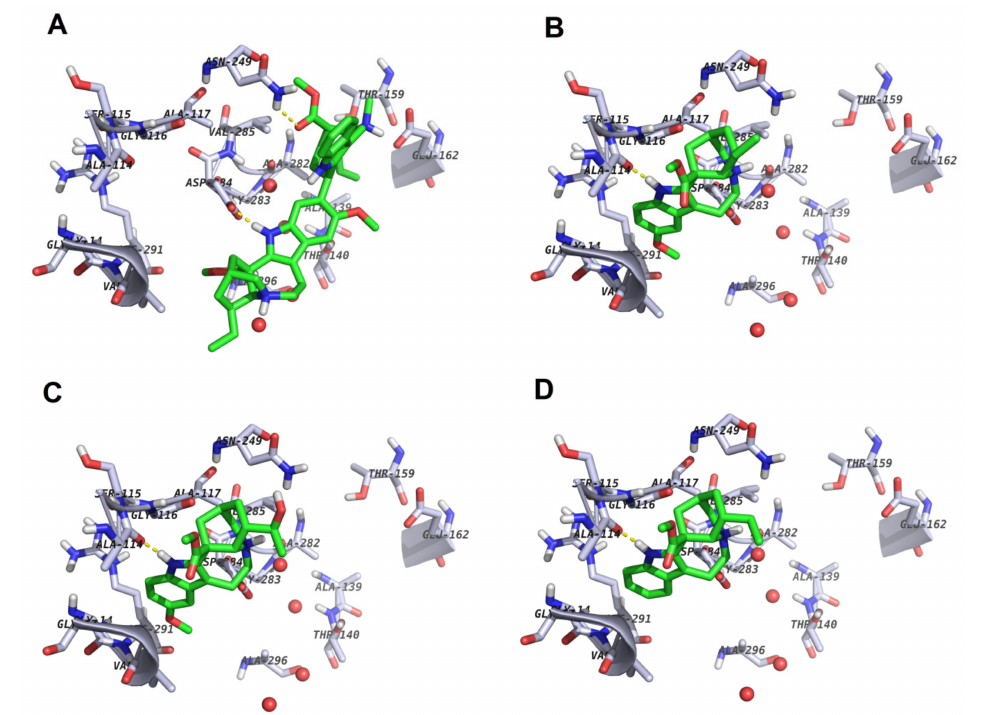
Figure 5. Binding interactions between the binding site with amino acid side-chains with the compounds; ( A ) compound 1 shown in green sticks, ( B ) compound 2 shown in green sticks; ( C ) compound 3 shown in green sticks, ( D ) compound 4 shown in green